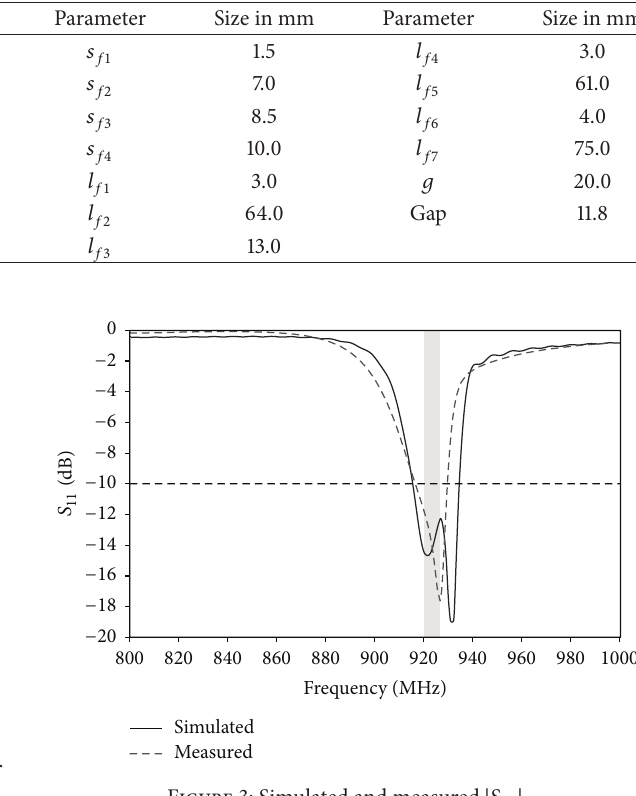
Figure 3: Simulated and measured | S 11 |